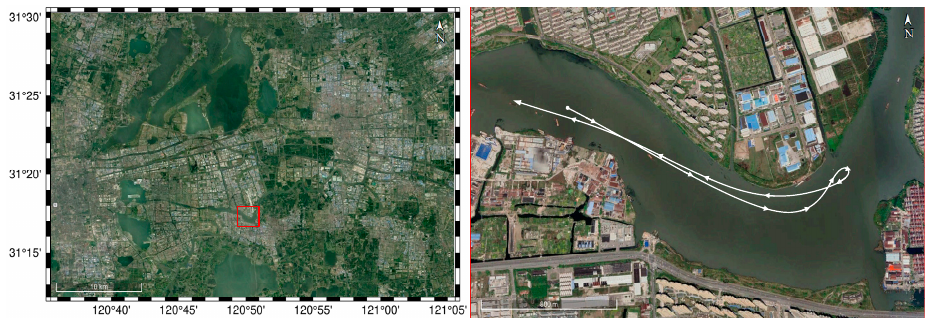
Figure 15. The location of the experiment and SSS sailing routes.